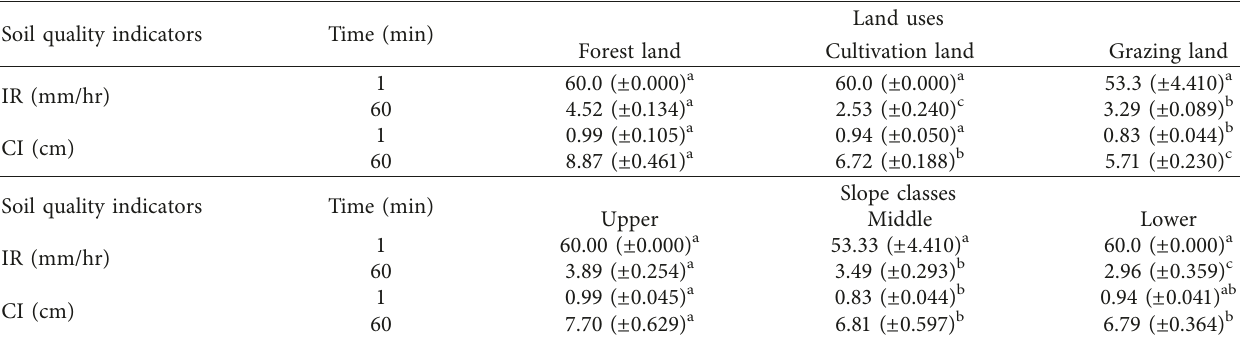
Table 3: Water infiltration rate (IR, mm/hr) and cumulative infiltration (CI, cm) of soils in relation to slope positions and land use types at 1 min (initial) and 60min (steady state) (mean ±